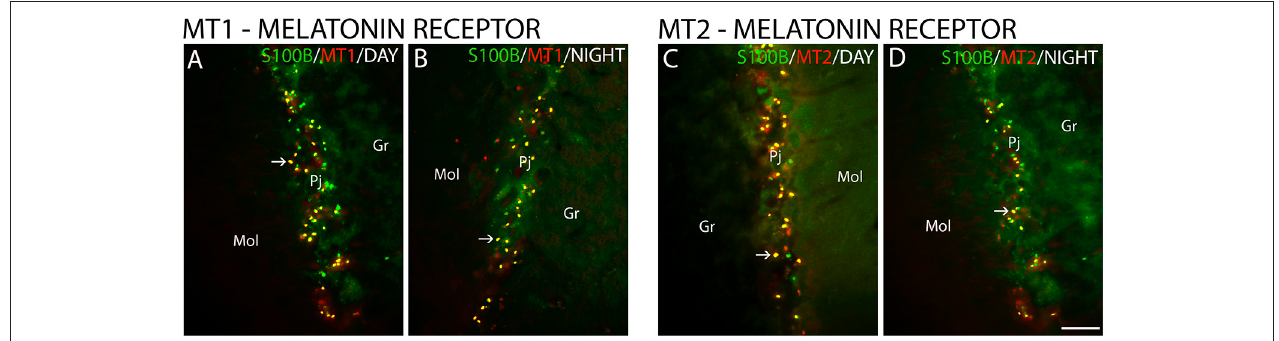
FIGURE 3 | The distribution of S100 β , MT 1 and MT 2 proteins in the cerebellar cortex in the primate Sapajus apella . Photomicrographs of frontal brain sections show MT 1 protein (A,B) (red) or MT 2 protein (C,D) (red) and S100 β (green) at two time points, one during the day (ZT 10) and another at night (ZT 19). The arrows indicate the co-localization (merge) of S100 β and melatonin receptors. Bar = 100 µ m.